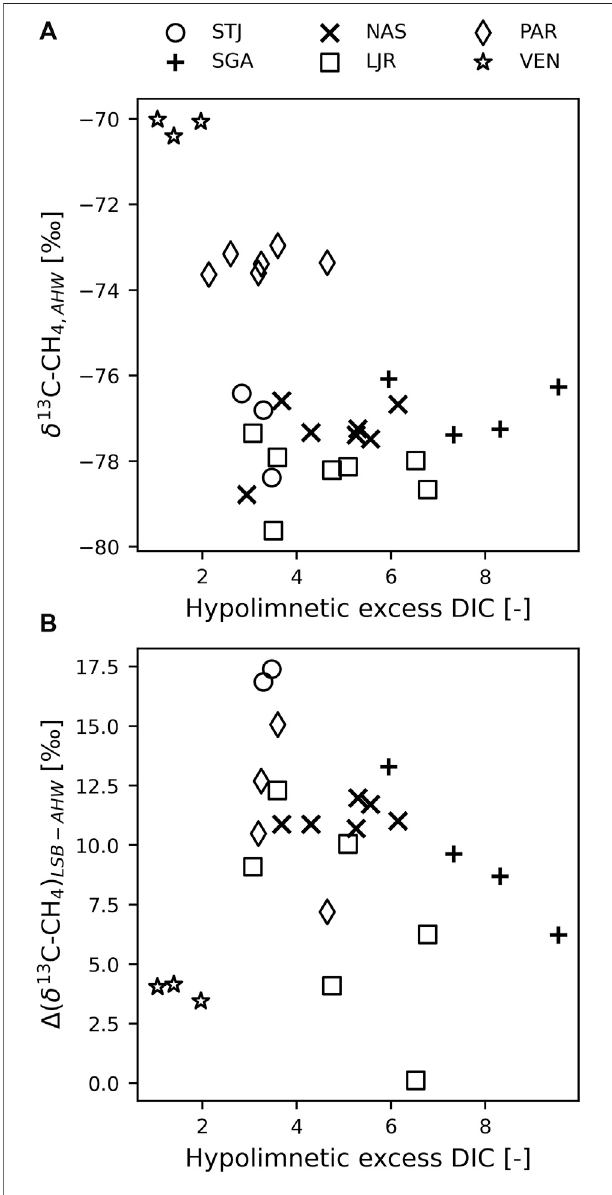
FIGURE5|(A) δ 13 C-CH 4 in anoxic hypolimnionwater (AHW)compared tothehypolimneticexcess dissolved inorganiccarbon (DIC),calculatedasthe difference in DIC concentration between bottom and surface water normalized by the concentration at the surface. (B) δ 13 C-CH 4 difference between AHW and littoral sediment bubbles (LSB) compared to the hypolimnetic excess DIC. In both panels, each point corresponds to 1 day when both δ 13 C-CH 4 and DIC were